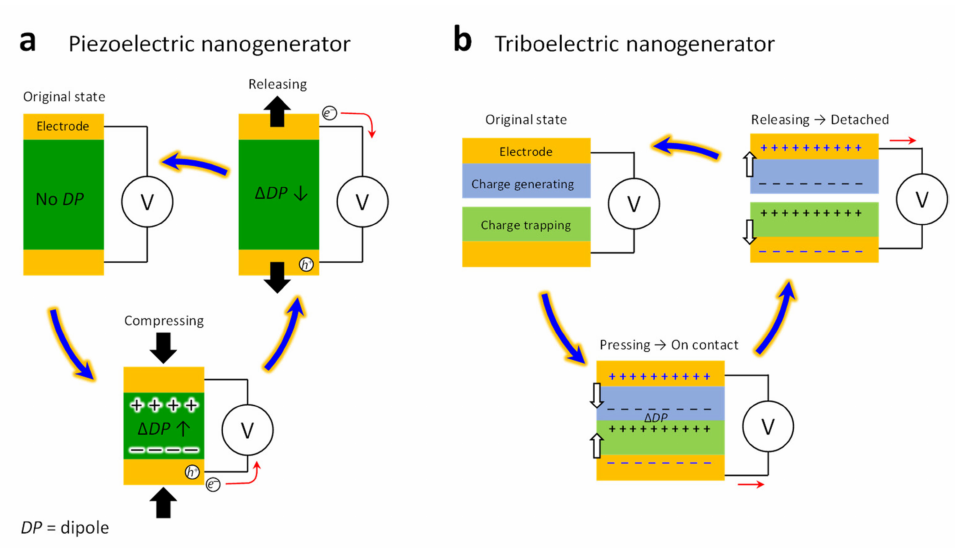
Figure 6. PENG- and TENG-based sensor